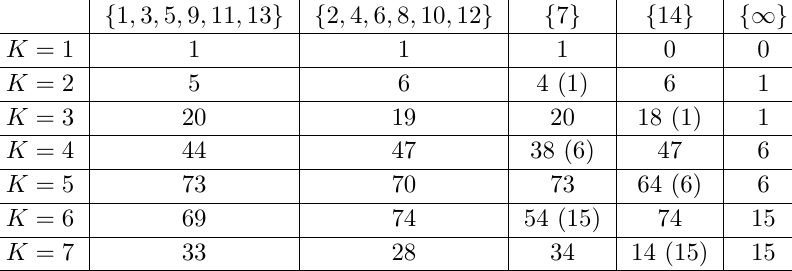
Table 11 . Number of Bethe roots for decomposed BAE with M = 14.